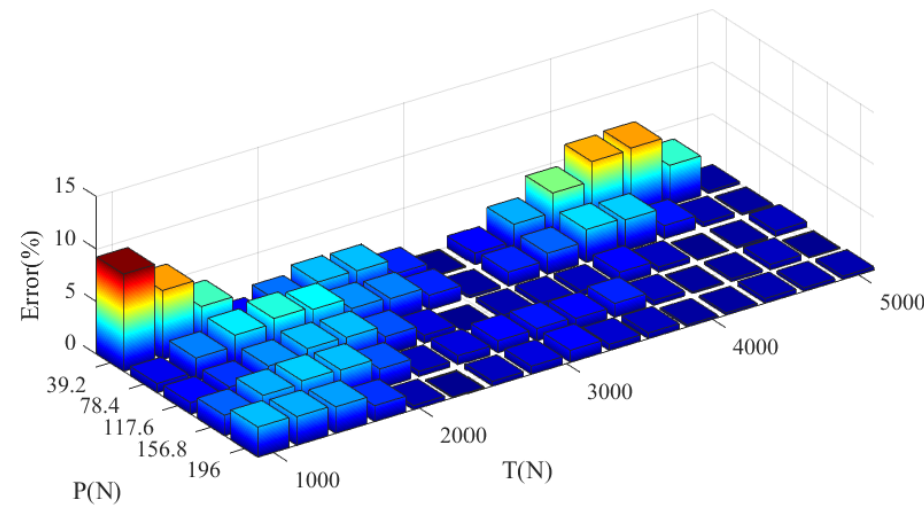
Figure 19. The relative error of deflections from present model with respect to the experimental measurements.